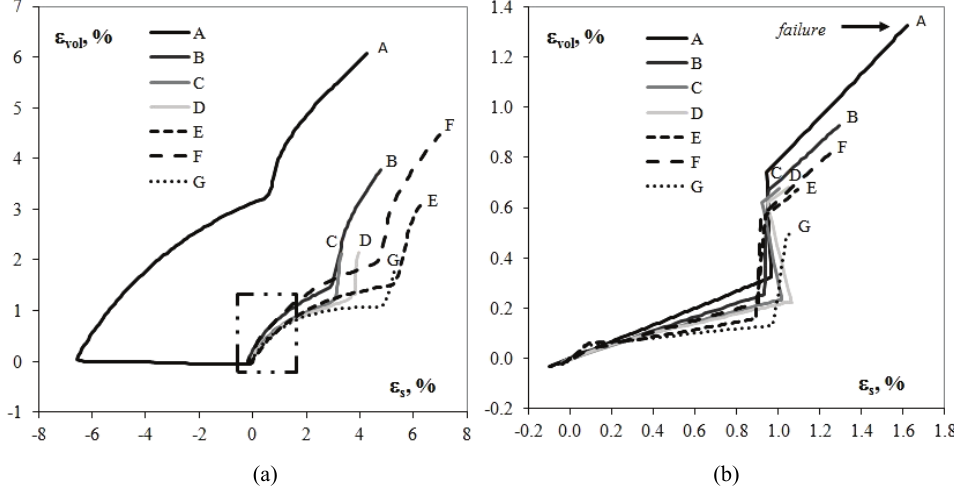
Fig. 2. (a) Experimental (triaxial) strain paths; range of theoretically predicted strain presented in the rectangle; (b) theoretical strain paths obtained with the use of CM model and parameters from